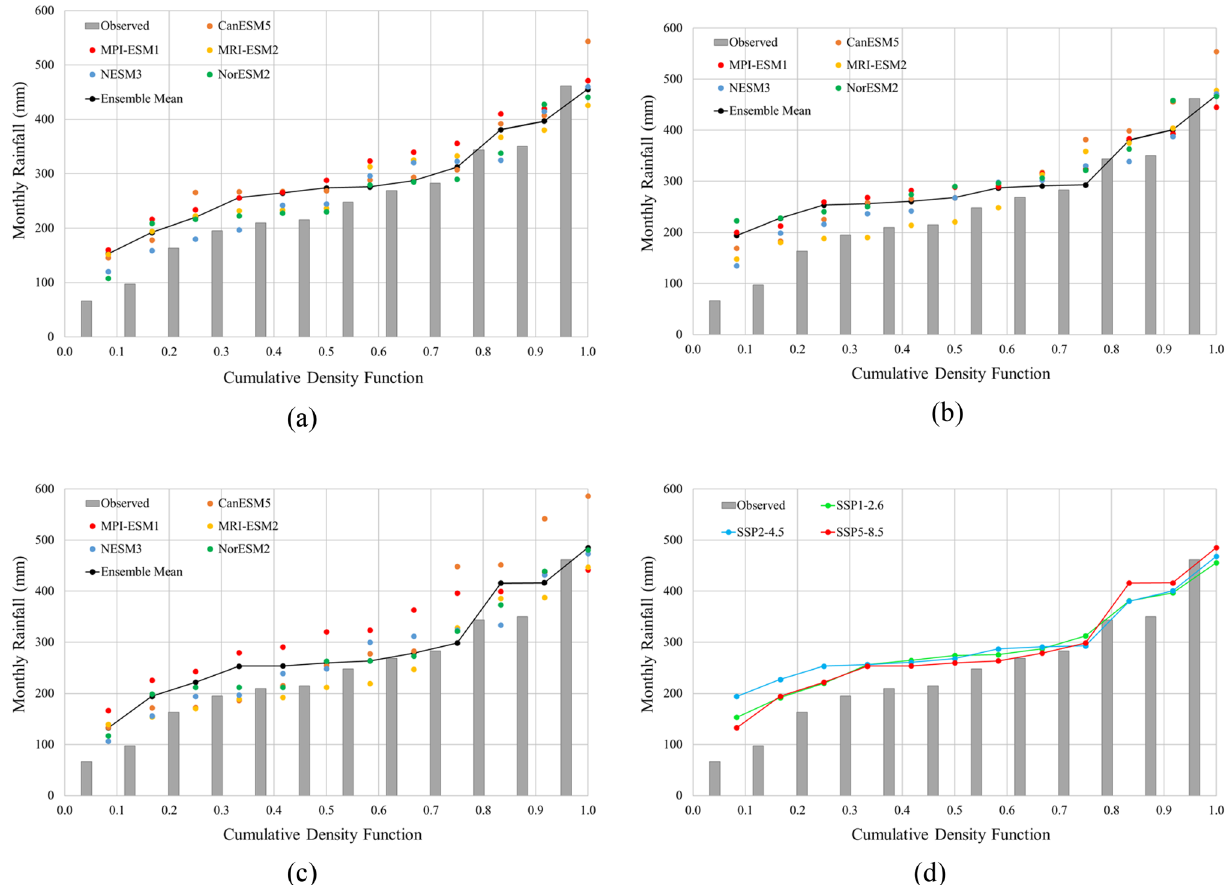
Fig. 5 Variability of downscaled individual CMIP6 model and multi-GCM ensemble under; a SSP1-2.6, b SSP2-4.5, c SSP5-8.5, and d multi- GCM ensemble for each scenario with recorded monthly